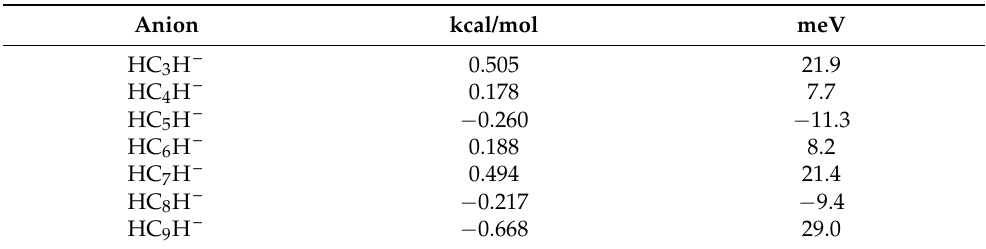
Table 3. Cis-trans anion energy splitting ∆ cis − trans estimated within the G4 composite model. Because all these values are smaller than the “chemical accuracy” of ∼ 1kcal/mol, one can expect that cis and trans HC n H anions coexist in space.